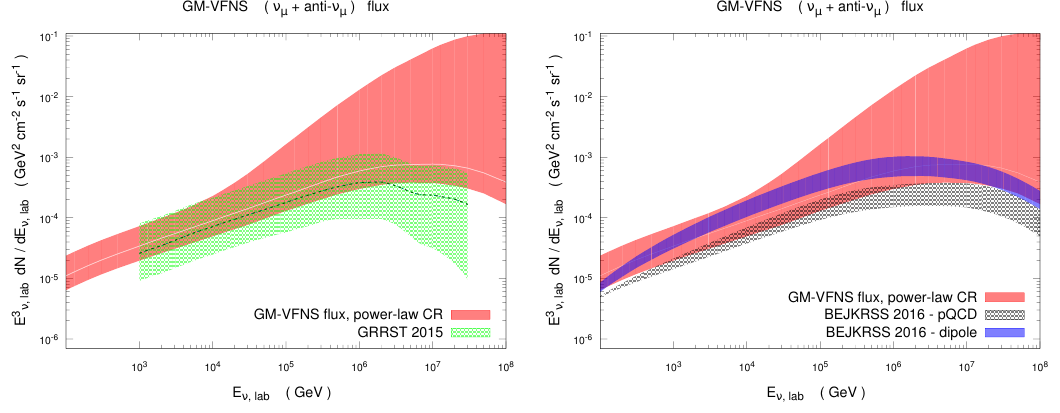
Figure 14 . Prompt-( (cid:23) (cid:22) + (cid:22) (cid:23) (cid:22) ) (cid:13)uxes as a function of neutrino energy E (cid:23); lab . Predictions according to the GM-VFNS computation of this paper, together with their uncertainty band, are compared to other recent selected ones available in the literature [49, 59], taking into account their uncertainty bands. The broken power-law CR primary spectrum is used as input in all predictions.